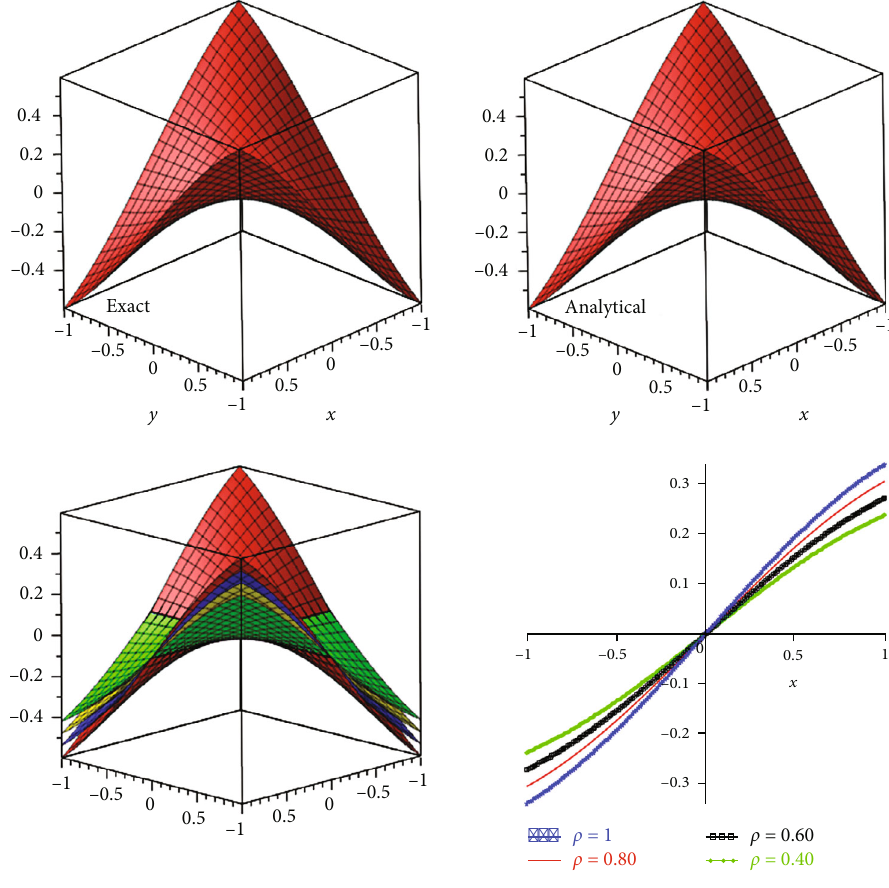
Figure 3: The graphical layout for problem